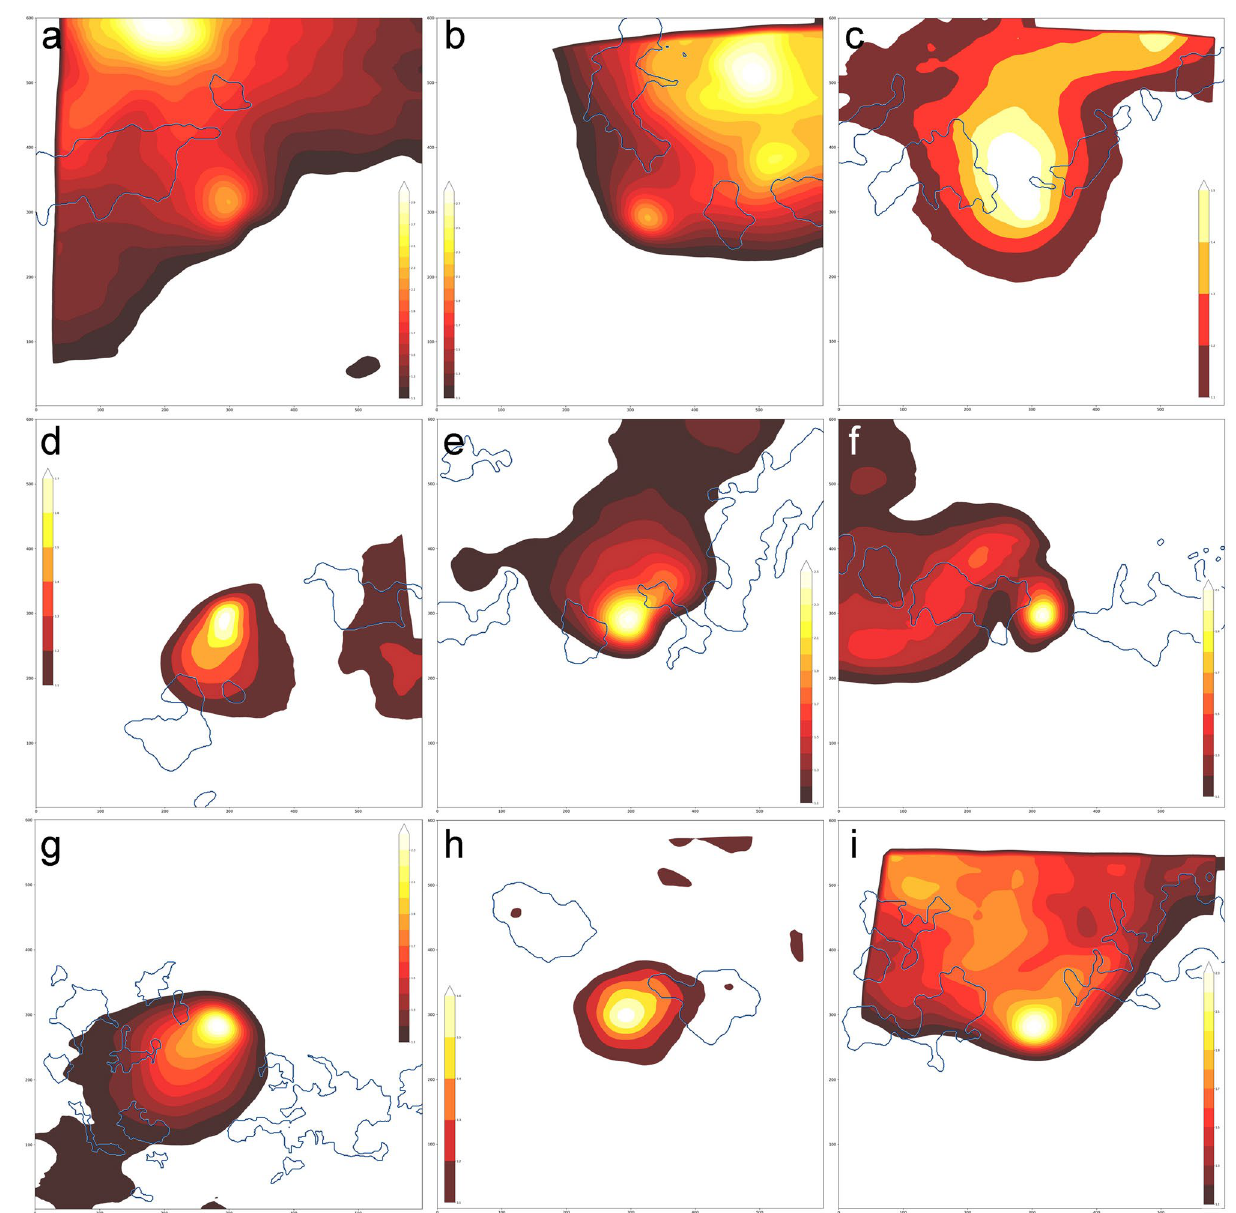
Figure 4. Contour plots of the territory of macular edema with boundaries of deep capillary congestion at recurrence. Patients with chronic stable branch retinal vein occlusion experienced recurrence of macular edema (ME) from baseline. ( a – c ) Apexes of the ratio of an increased retinal thickness (RIRT) were in the capillary nonperfusion area (NPA) of the affected side. The other local maximums were in the foveal avascular zone (FAZ). Capillary congestion of the deep capillary plexus (DCP-C) surrounded the local apexes of RIRT. ( d – f ) Unlike the cases depicted in ( a – c ), the apexes of RIRT existed in the FAZ. Some DCP-C segments were not involved in ME. ( g – i ) Similar to the cases depicted in ( d – f ), the apexes of RIRT were in the FAZ. Most DCP-Cs existed on the border of ME territories, and in other DCP-Cs ( h ), ME has just DCP-C was observed in all eyes in this study, but ME recurred in about a third. Suzuki et al. observed leakage from capillary congestion in one-third of BRVO patients 16 . Moreover, in 70% of eyes with capillary congestion, ME resolved; however, in the remaining 30%, it did not 16 , a result that resembles our ME recurrence rate. At baseline, SCP-C was not found in all of the eyes and its area was smaller than that of DCP-C. SCP-C formation seems to be slower than the development of DCP-C due to lack of collaterals and higher net pressure caused by the shorter capillary distance in SCP 31 . Early formation of DCP-C can reduce the overall intraluminal pressure to the occluded area, and the possibilities of the growth of SCP-C may lessen consequently. The total number of injections from the initial visit to baseline was also a risk factor for ME recurrence in chronic BRVO. According to real-world data that do not strictly control the treatment with injections, the num- ber of injections tends to be determined by the extent of ischemia of BRVO 34,35 . In that context, in patients who